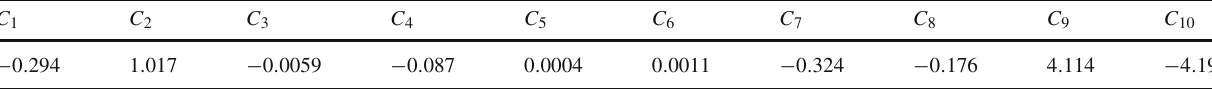
Table 2 The Wilson coefficients at the scale μ b = 4 . 2 GeV, to NNLL accuracy in the